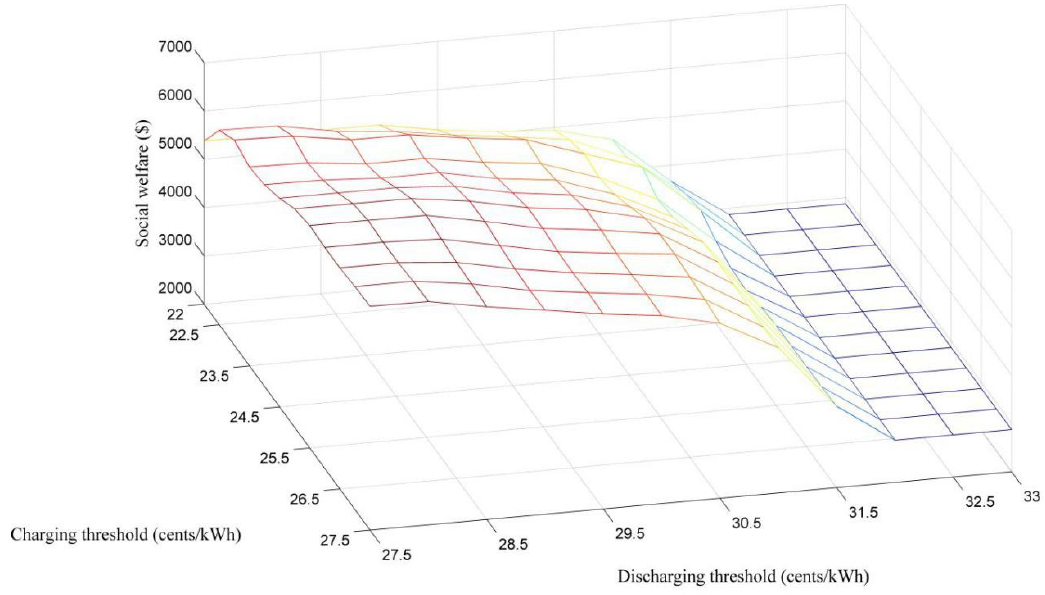
Figure 9. Effects of the charging and discharging thresholds.